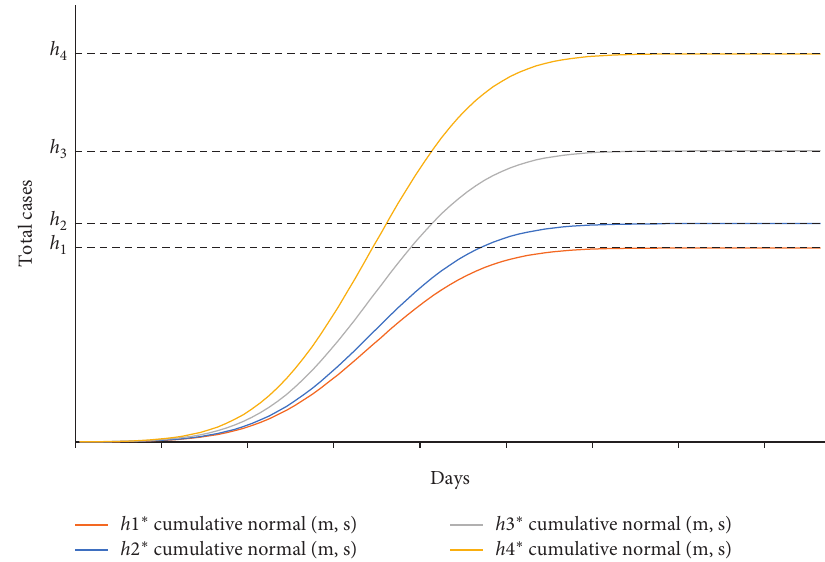
Figure 2: COVID-19 active